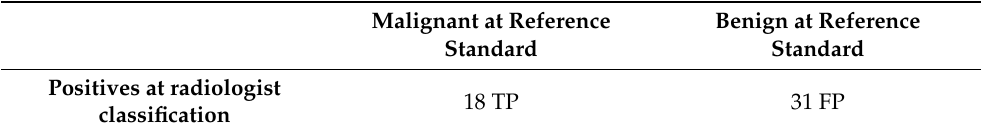
Table 3. Reference standard and radiologist classification results of the tested patients. Number of true positive (TP) and false positive (FP).